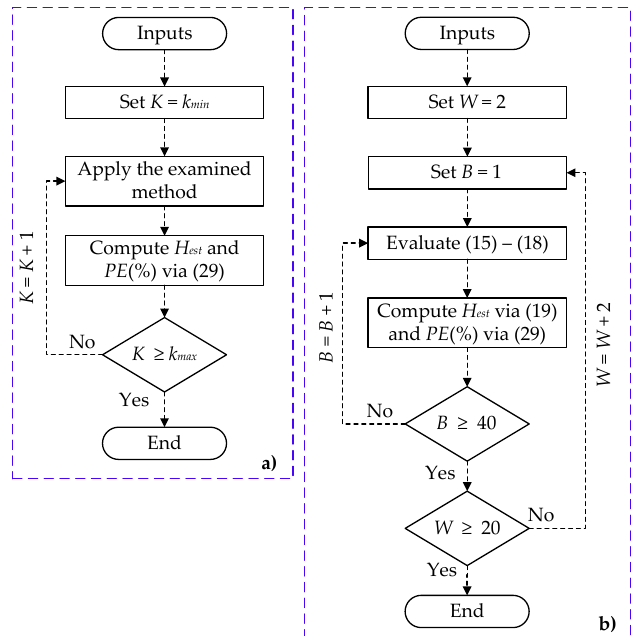
Figure 4. ( a ) Procedure used to quantify the impact of window length on the accuracy of Method #1, Method #2, Method #3, and Method #4. ( b ) Procedure used to quantify the impact of window length on the accuracy of Method